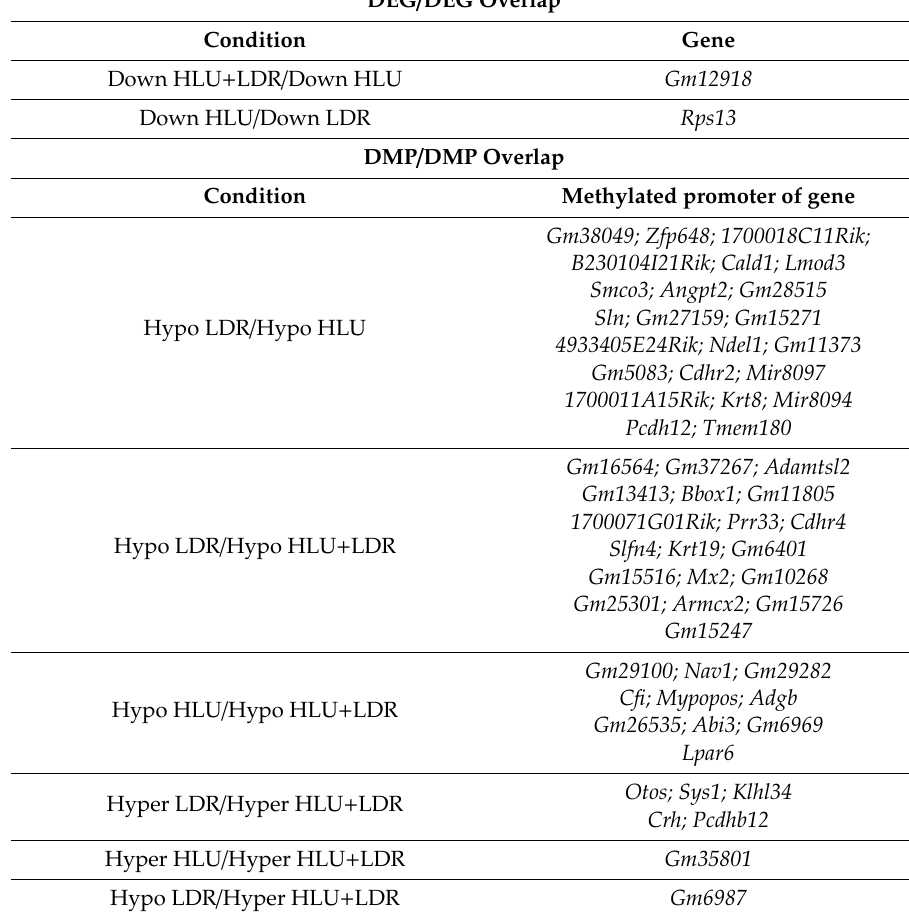
DEG / DEG Overlap